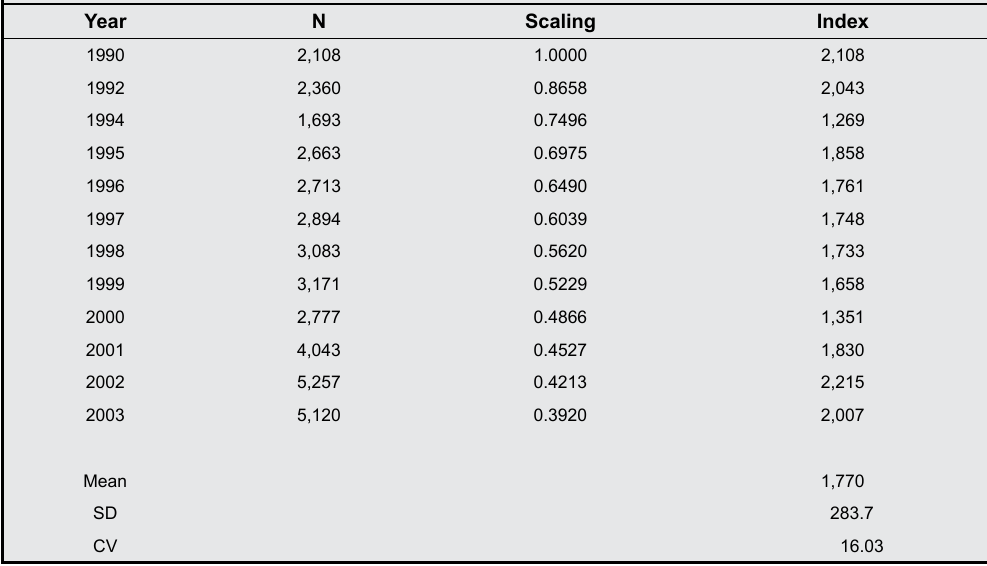
Table 1. Basic data on maximum counts (N) of grey seals along the Swedish Baltic coast during a 13 year period. For the estimate of the minimum coefficient of variance (CV), the actual counts in the second column are scaled to zero growth rate in the fourth column by multiplication with the third column. The third column is based on the estimated mean growth rate in the population (λ= 1.0747, Fig.